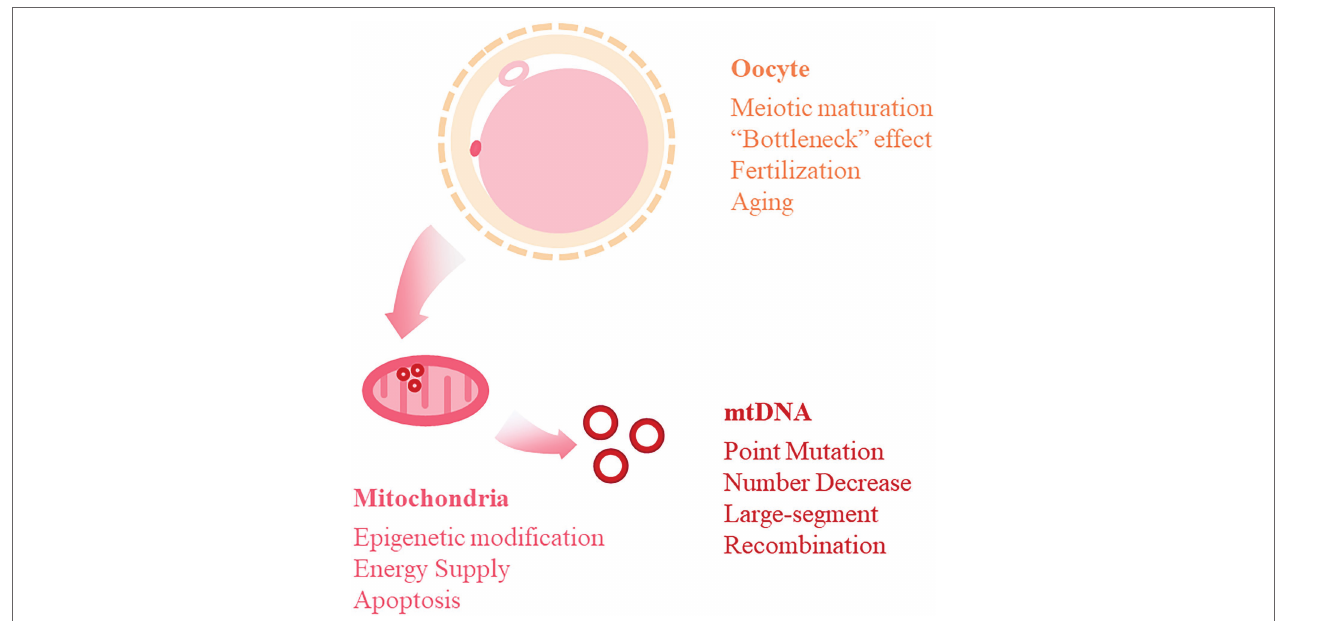
FIGURE 1 | Summary of mitochondria and mtDNA function in